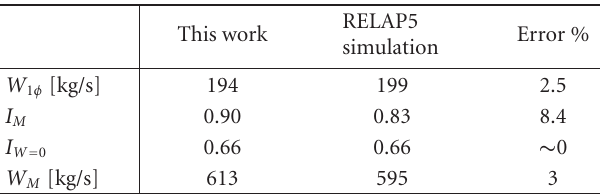
Table 2: Comparison of results obtained from RELAP5 simulations and the present